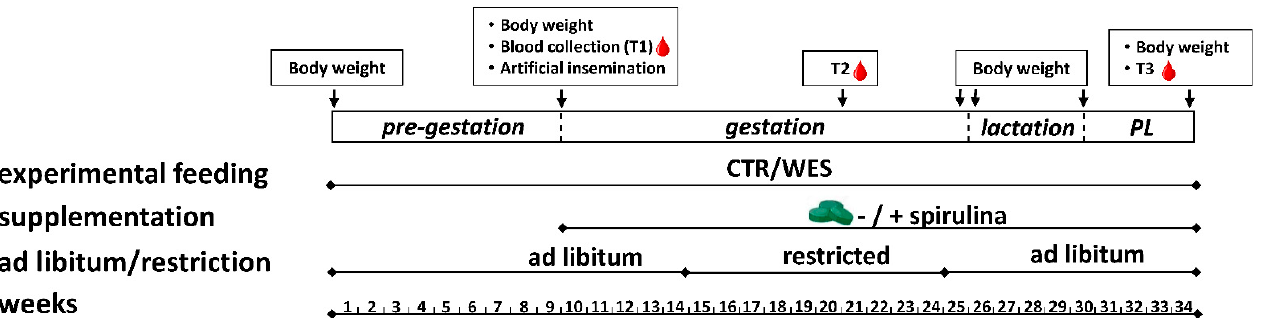
Figure 1. Schematic representation of the feeding experiment performed on female crossbred pigs in two runs (2019 and 2020) from spring to winter (34 weeks in total). Experimental sows were fed a control (CTR) or Western (WES) diet from the pre-gestation period to the post-lactation (PL) period for a total of 34 weeks. At artificial insemination, spirulina supplementation was started for half of both diet groups. Body weight was recorded at the start and end of each experimental period. Blood was collected at three time points (T1, T2, T3).